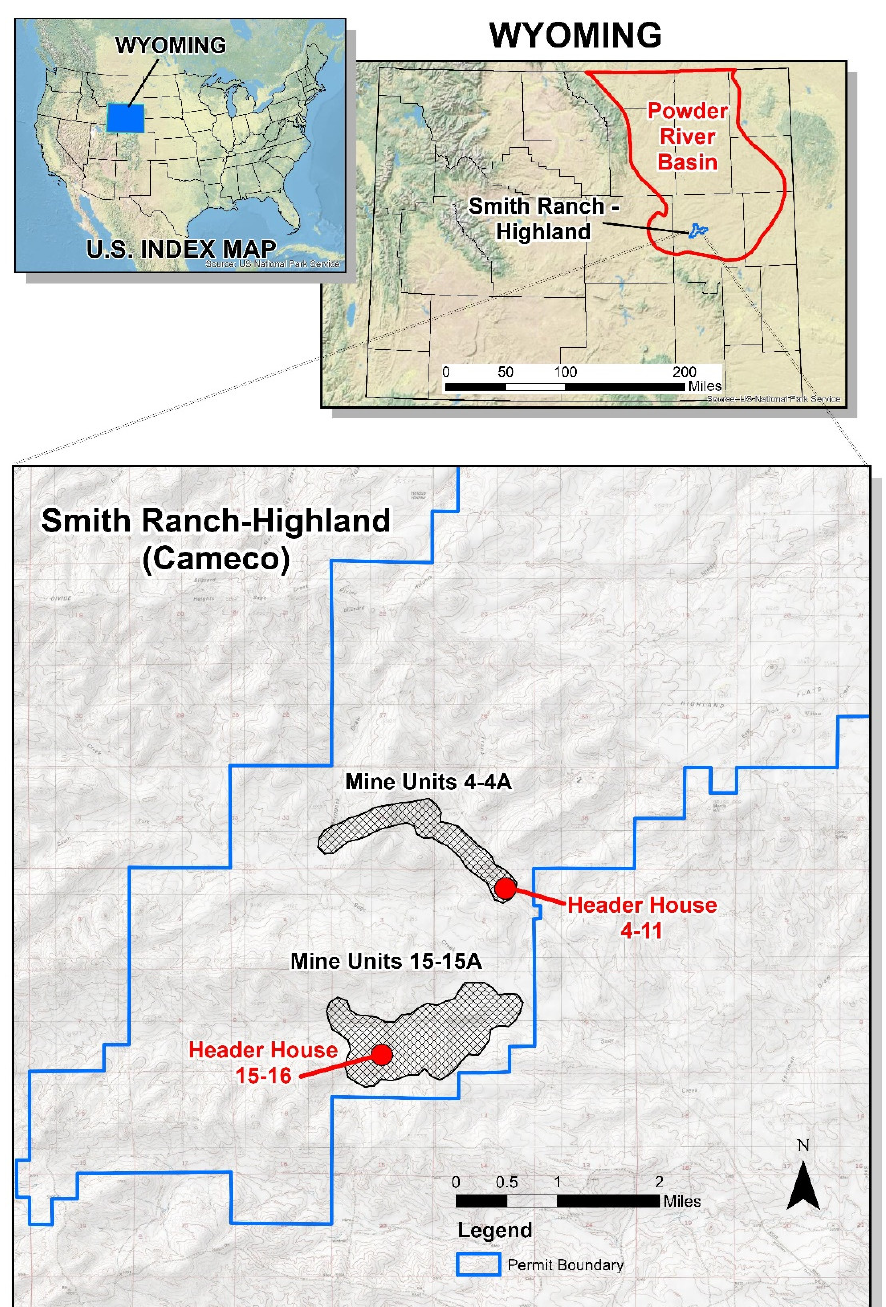
Figure 1. Location of Smith Ranch-Highland Facility in Wyoming, showing mining unit 4A and HH 4–11, where the multi-well reductive amendment test was conducted. Also shown is the location of HH 15–16 in mining unit 15, where the single-well push-pull dithionite tests discussed in Section 1.2 were conducted. were